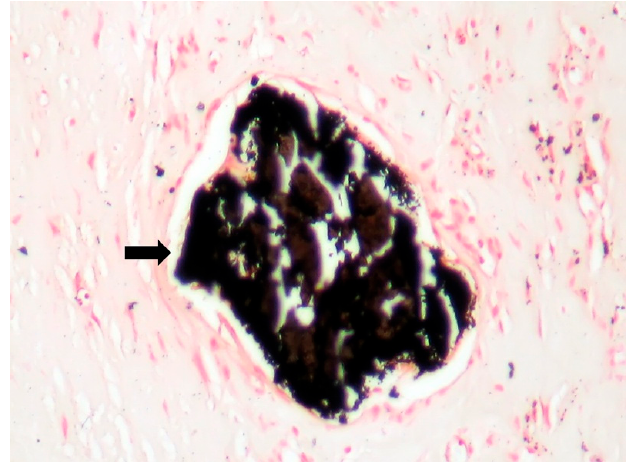
Figure 7. Giant cells (arrows) (HE stain × 40).